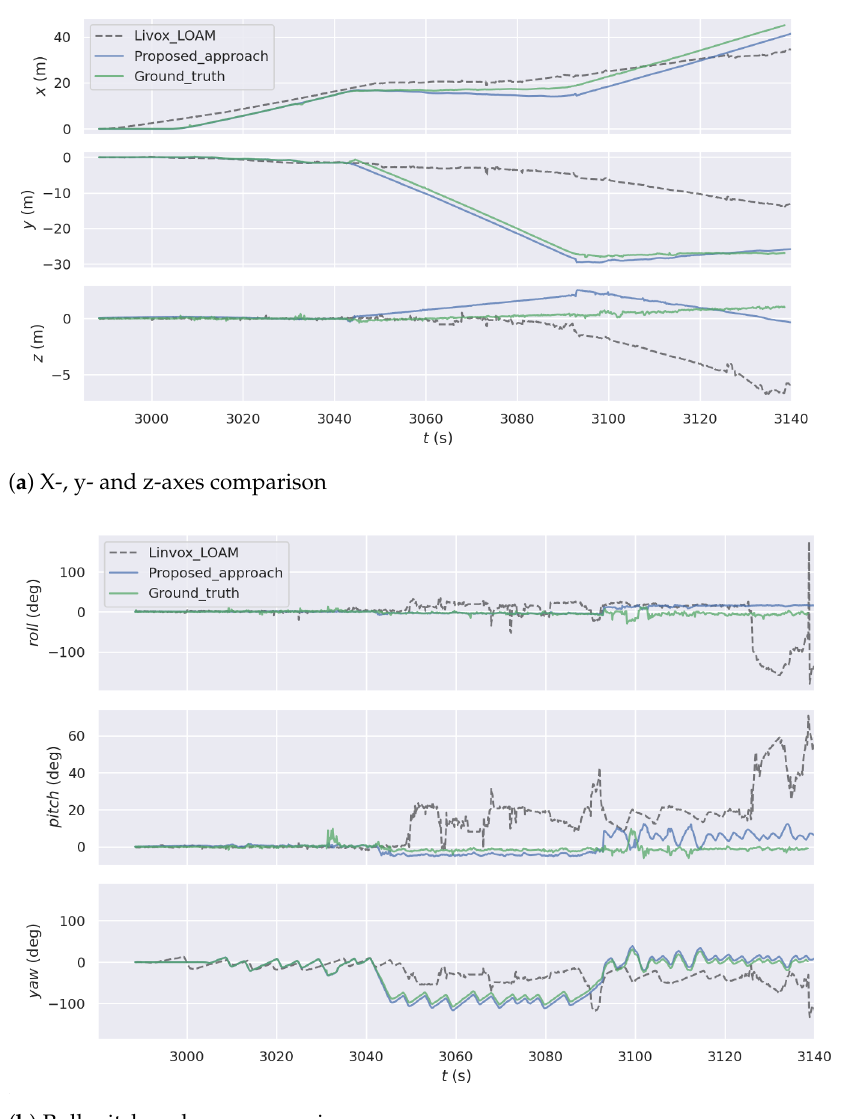
Figure 11. Odometry Comparison between proposed approach, Livox-LOAM and the ground